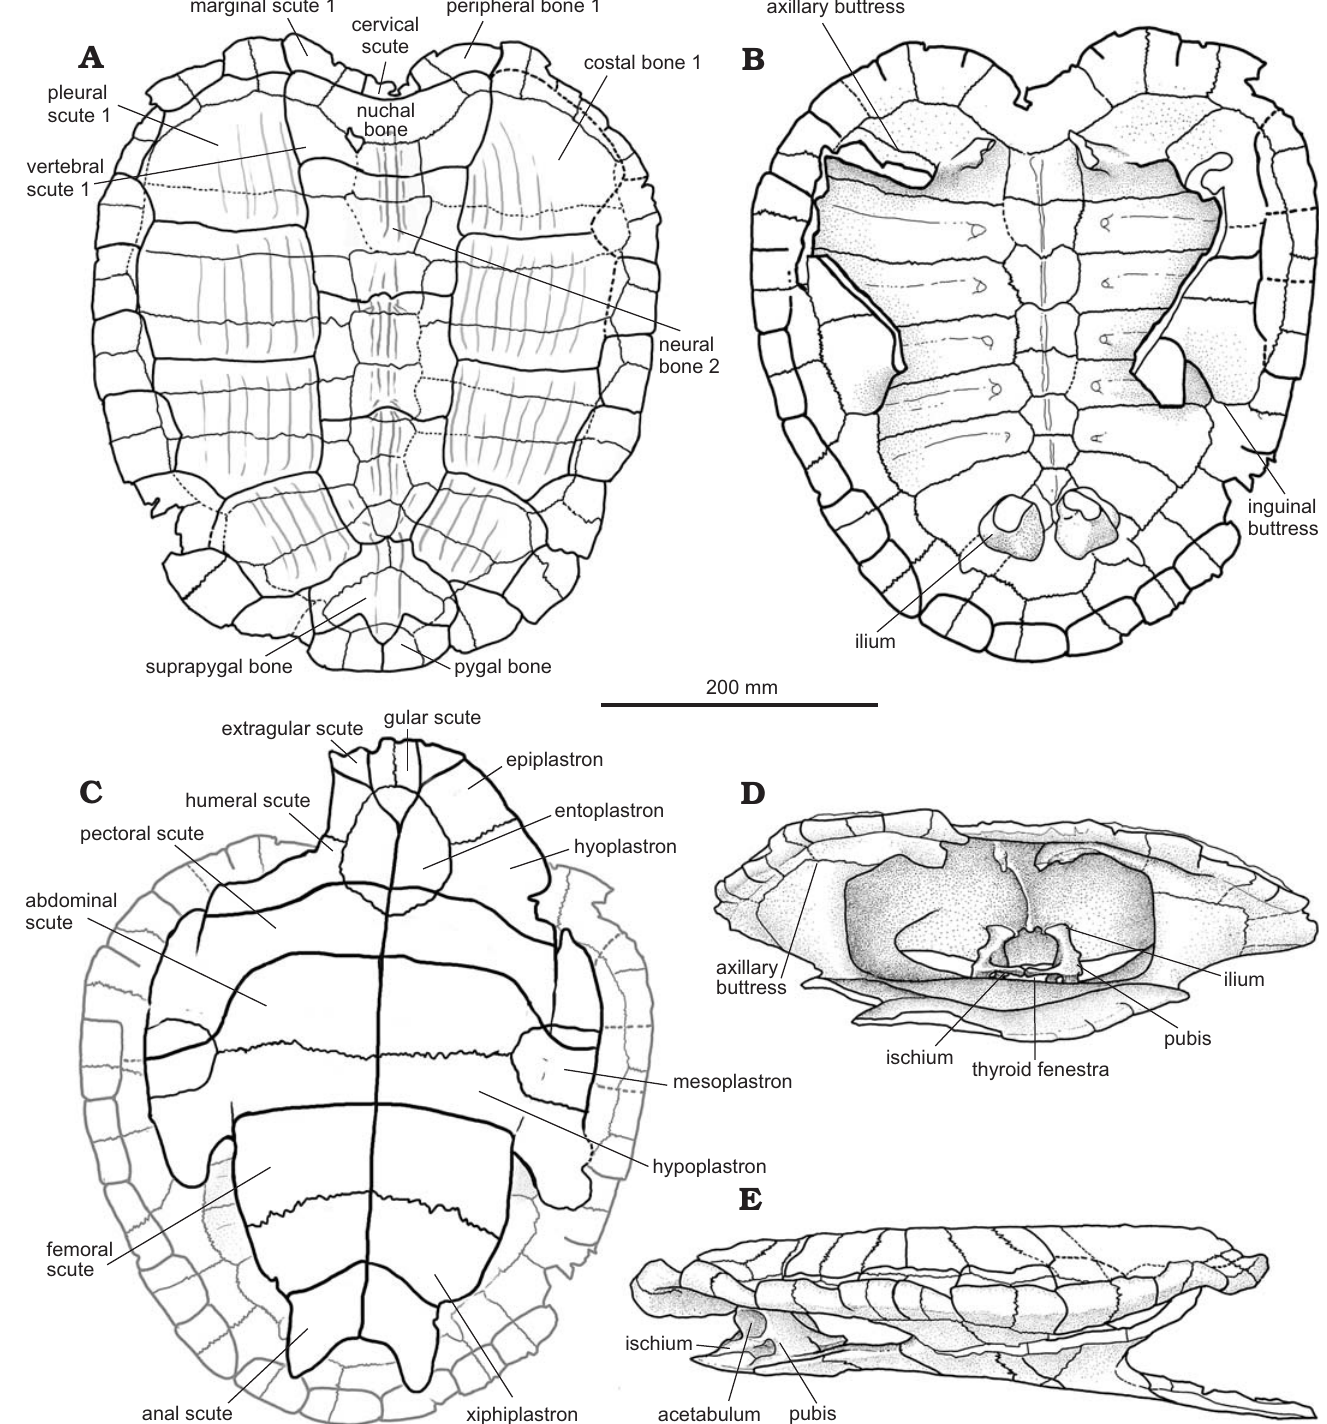
Fig. 5. Explanatory drawings of the holotype of the panchelid turtle Rionegrochelys caldieroi gen. et sp. nov. (MPCA-AT 258) from Parrita site, Upper Cretaceous. Carapace in dorsal ( A ) and visceral ( B ) views. Plastron in ventral view ( C ). Carapace and plastron in anterior ( D ) and lateral ( E ) views. Note suturally attached pelvic